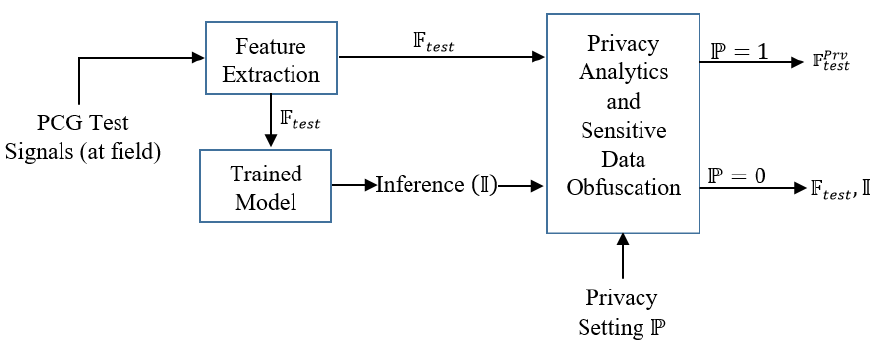
Figure 5. Functional workflow of the proposed method.